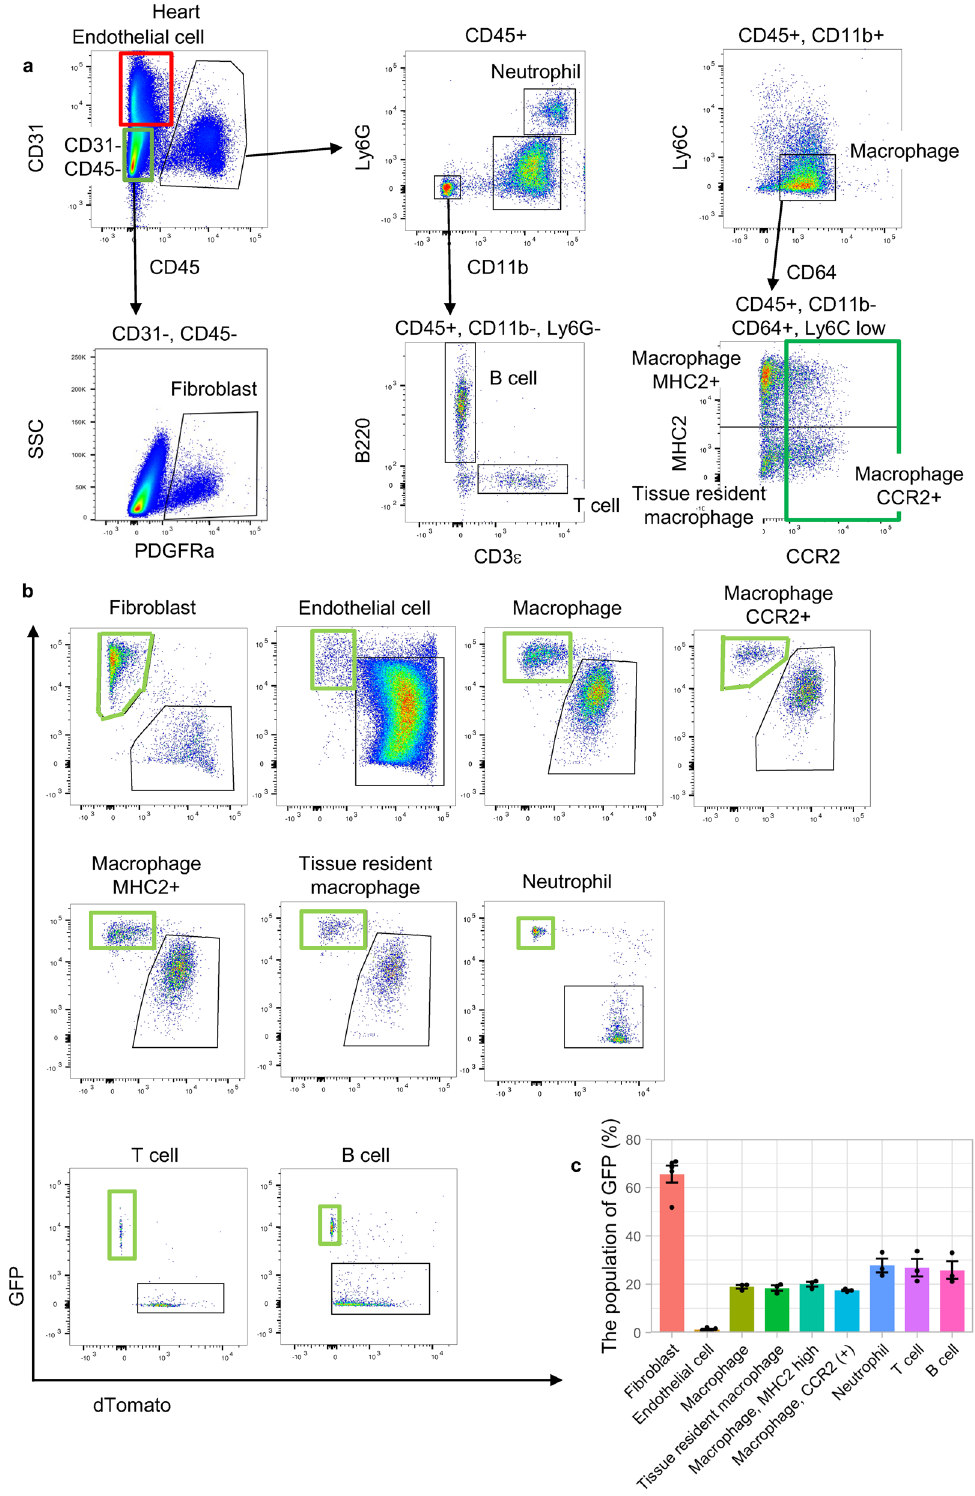
Figure 2. Flow cytometric analysis of nonCMs in SMmTmG mice. ( a ) The representative gating schema of murine hearts. ( b ) GFP expression in each cell type in the heart. ( c ) Summary of GFP expression in the heart (fibroblasts and endothelial cells: n = 5, others: n =